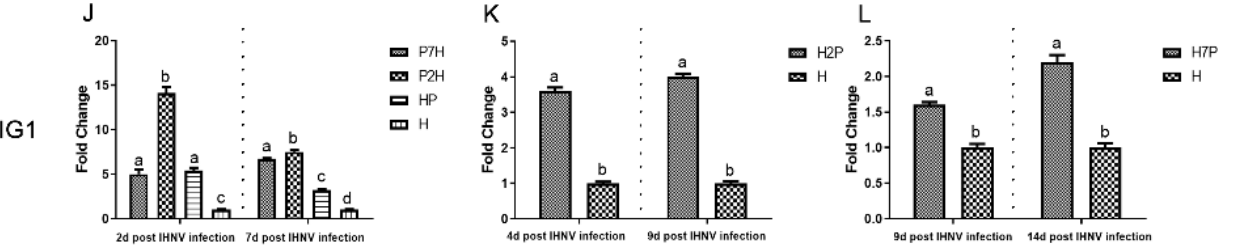
Figure 9. Gene expression of immune-related factors in the liver based on qRT-PCR evaluation. Data represent relative values with respect to IFN1 , Mx-1 , ISG15 , and VIG1 gene expression. Different letters indicate statistically significant differences ( p < 0.05). ( A – C ) IFN1 ; ( D – F ) Mx-1 ; ( G – I ) ISG15 ; ( J – L ) VIG1 .